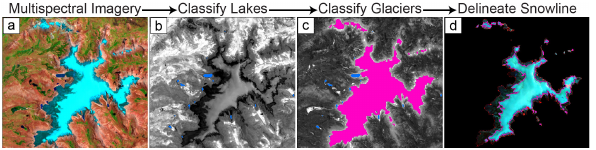
Fig. 3. Flow chart indicating the general methodology used, applied to a Landsat TM image from 15 October 2009. The images (a) are used to classify lakes (b) using a normalized difference water index (NDWI) algorithm (lakes: blue). Glaciers (c) are then classified us- ing a TM3/TM5 & TM1 algorithm (Landsat TM/ETM + ) and clip- ping of the data with the previously created lake mask to remove in- correctly classified lakes (shown on TM3/TM5 image – lakes: blue, QIC: pink). The QIC (or other glacier) outline is then used to clip calibrated reflectance data (d) to obtain snow-line information for that area alone using MESMA. See text for abbreviation explana-